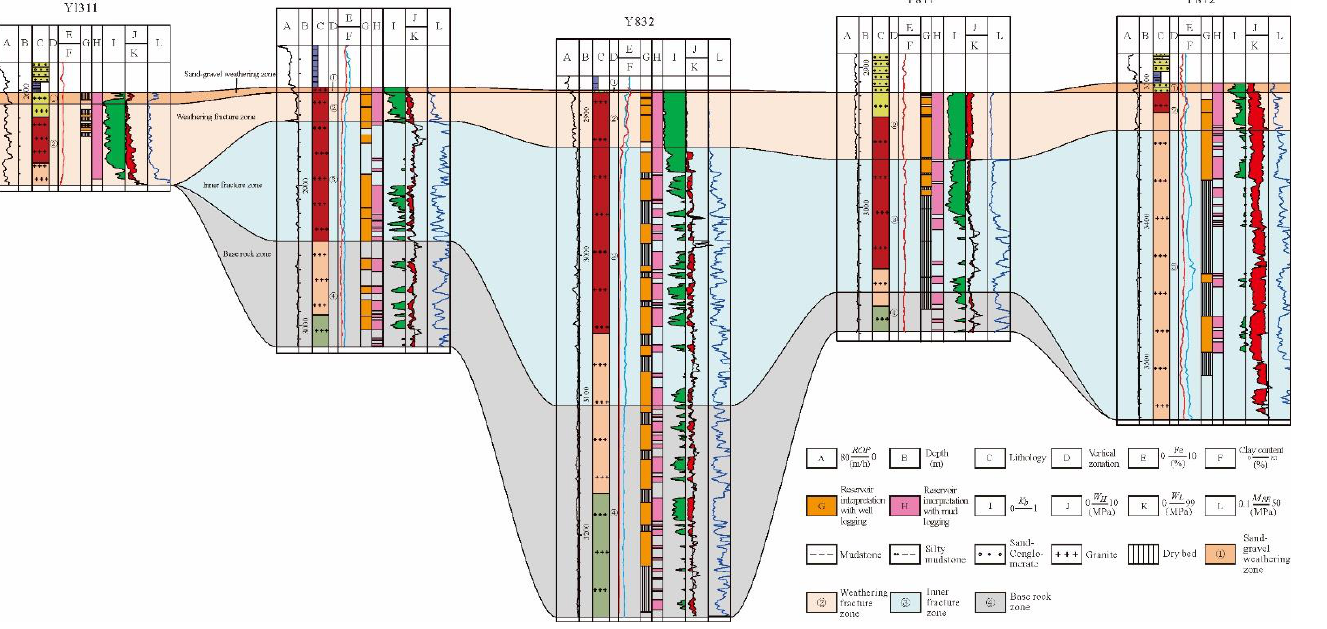
Figure 5. Mud-logging characteristics of zonation and reservoir interpretation with mud-logging data of intrusive rock buried-hill of Well 1311~Y831~Y832~Y811~Y812, location of the section is shown in Figure 1a,b.